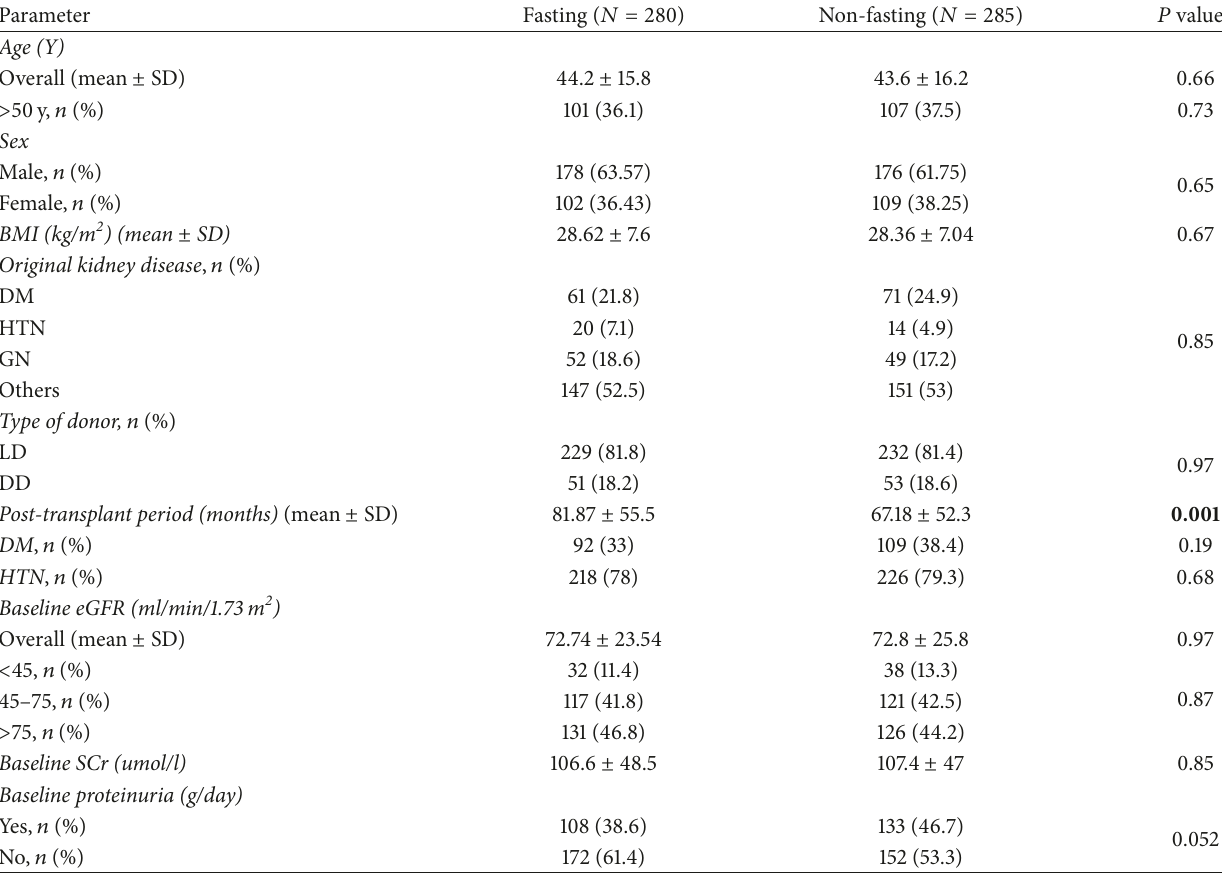
Table 1: Basic demographic and clinical data in fasting and non-fasting groups a , b